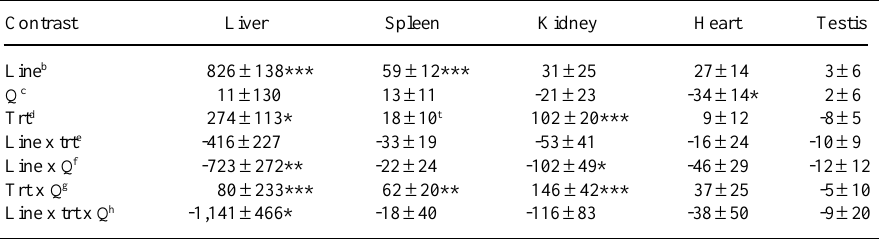
a See Table 1 for description of lines. b High-growth background line versus control background line. Contrast is TM - TC. c Transgenic mice versus nontransgenic mice. Contrast is T - N. d Zinc supplementation versus no supplementation. Contrast is Z - C. e Contrast is (TC x C) + (TM x Z) - (TC x Z) - (TM x C). f Contrast is (TC x N) + (TM x T) - (TC x T) - (TM x N). g Contrast is (C x N) + (Z x T) - (C x T) - (Z x N). h Contrast is (TC x C x T) + (TC